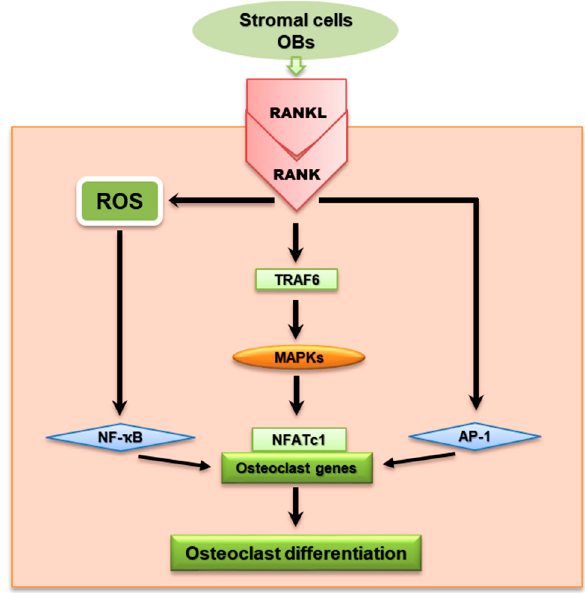
Figure 1. RANKL/RANK signaling pathway from stromal cells/OBs showing downward signaling molecules to the transcription factors in the nucleus that regulate OC differentiation. RANKL is an important cytokine in the OC signal pathway together with various intracellular signaling molecules—such as TRAF, MAPKs, NF- κ B, and NFATc1—which are essential for regulating OC differentiation.